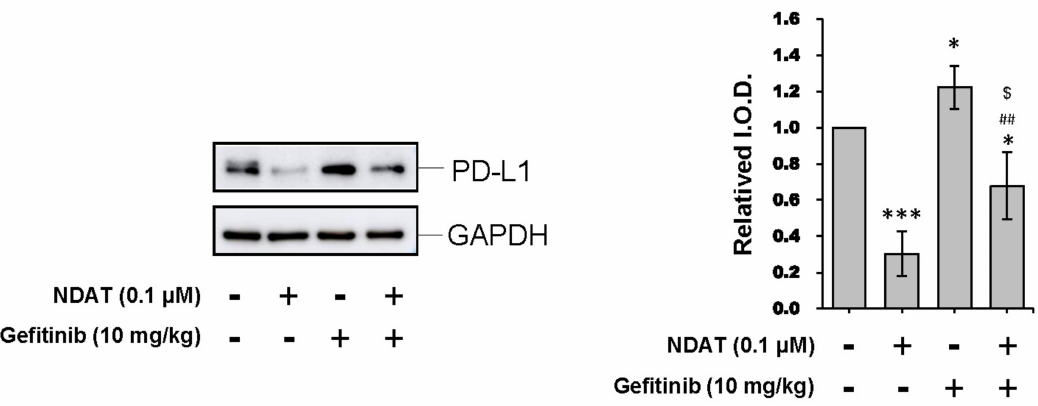
Figure 8. NDAT inhibited PD-L1 accumulation in HCT116 cell-derived xenograft tumor tissues. Tumor tissues were homogenized, and total proteins were extracted. Western blotting analyses were conducted by PD-L1. The number of independent experiments N = 4. Data are expressed as mean ± SD; * p < 0.05, *** p < 0.001, compared with untreated control; ## p < 0.01, compared with NDAT; $ p < 0.05, compared with